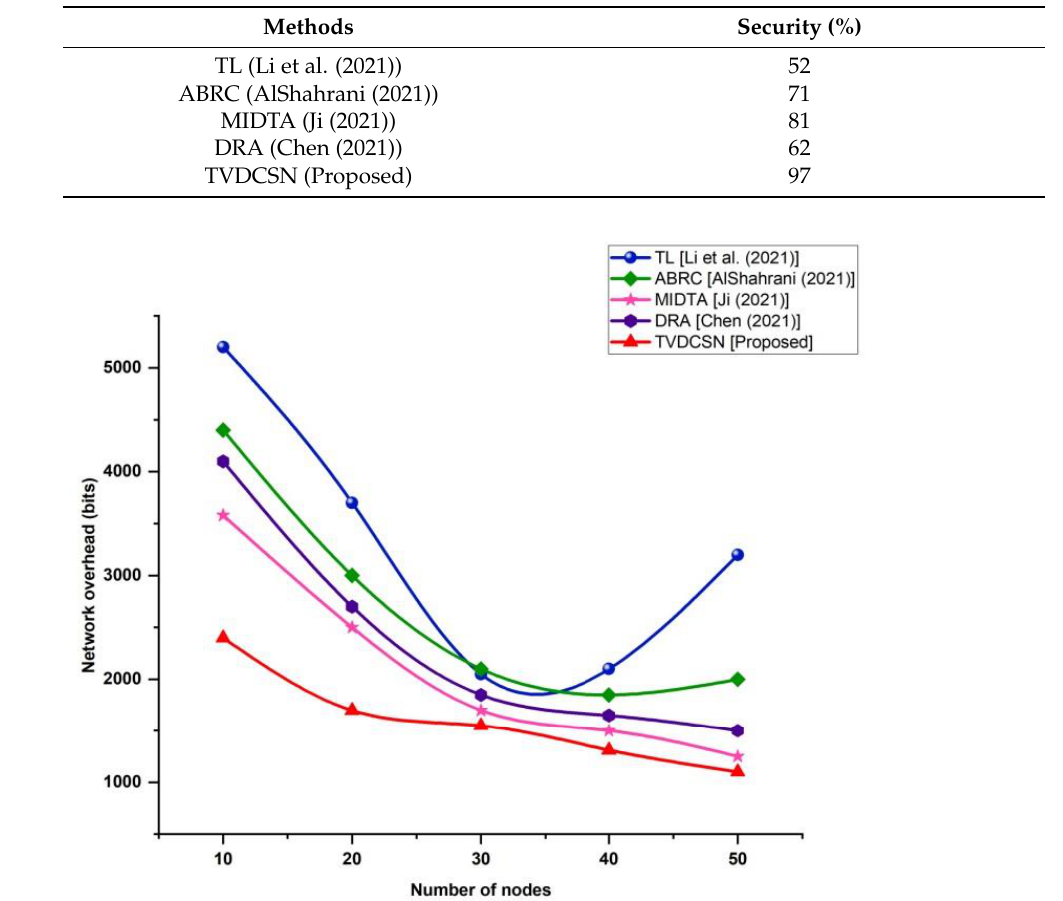
Table 3. Values of proposed and existing methods of security.